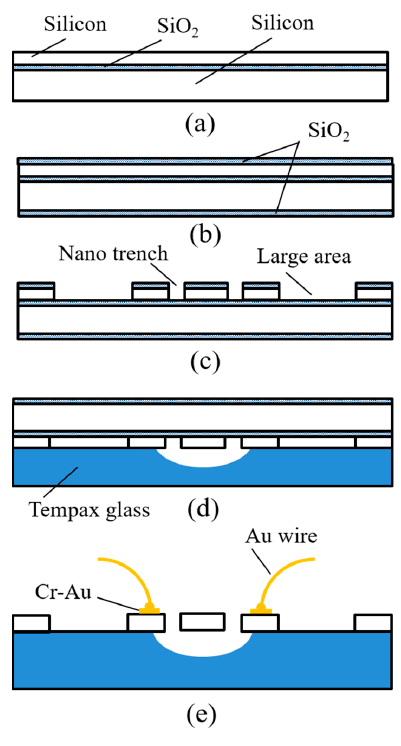
Figure 3. Fabrication process. ( a ) Silicon on insulator (SOI) wafer (7 µ m/ 1 µ m/ 300 µ m); ( b ) thermal oxidation; ( c ) combination of electron beam (EB) lithography, photolithography, and deep reactive ion etching (RIE) process; ( d ) anodic bonding; ( e ) backside silicon etching, SiO 2 removal, and metal contact pads.